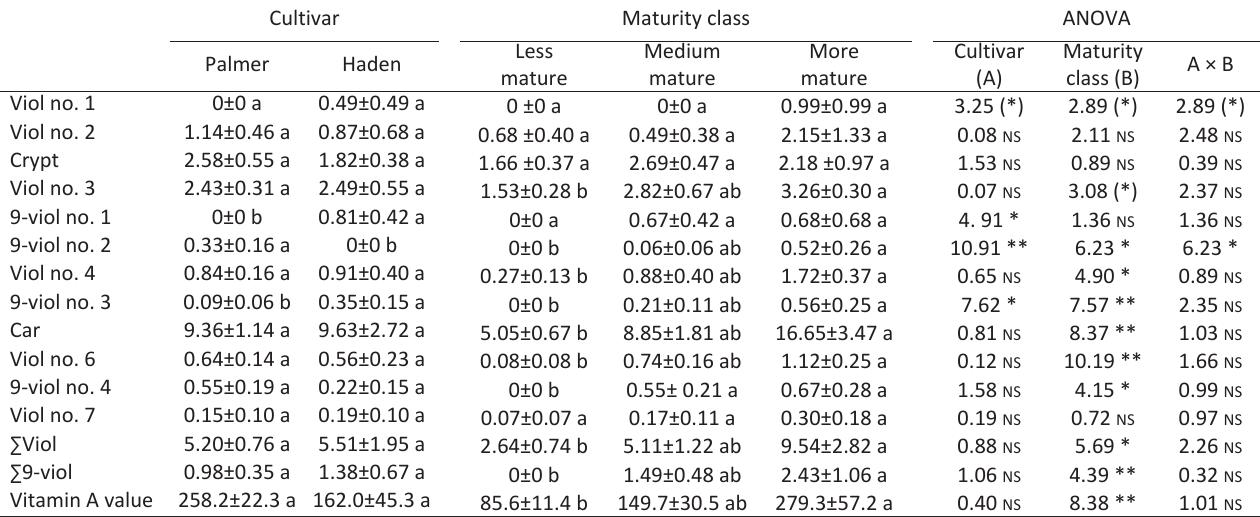
Mean±SE; 0=not detected. Within cultivar and within TRS maturity class means followed by different letters are statistically different (Bonferroni's test, (*) P<0.10; * P<0.05; **P<0.01; NS =not significant). ∑Viol= total all-trans-violaxanthin esters; ∑9-Viol= total 9-cis-vio-